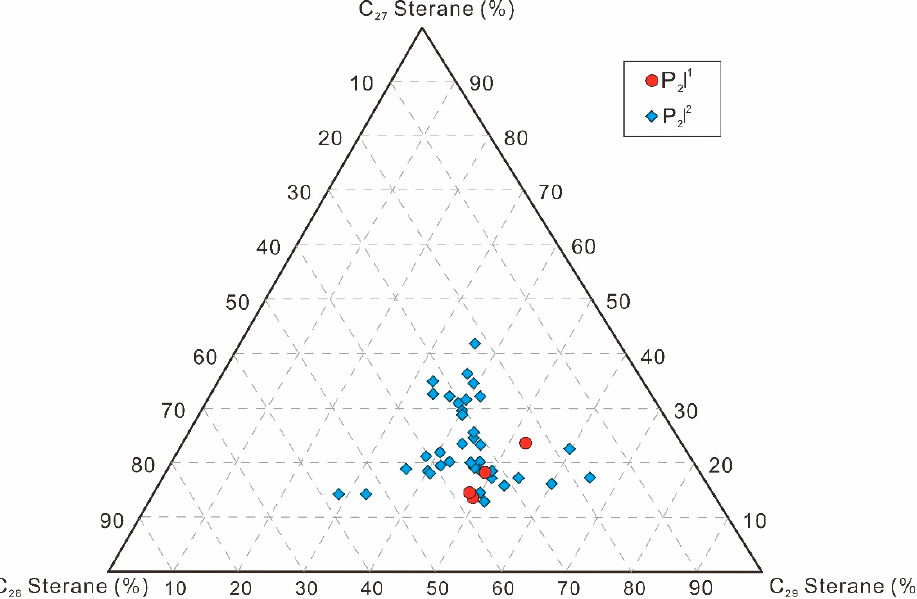
Figure 4. Ternary diagram of the relative percentages of the C 27 , C 28 , and C 29 regular steranes in the P 2 l source rocks in the Jimsar Depression.